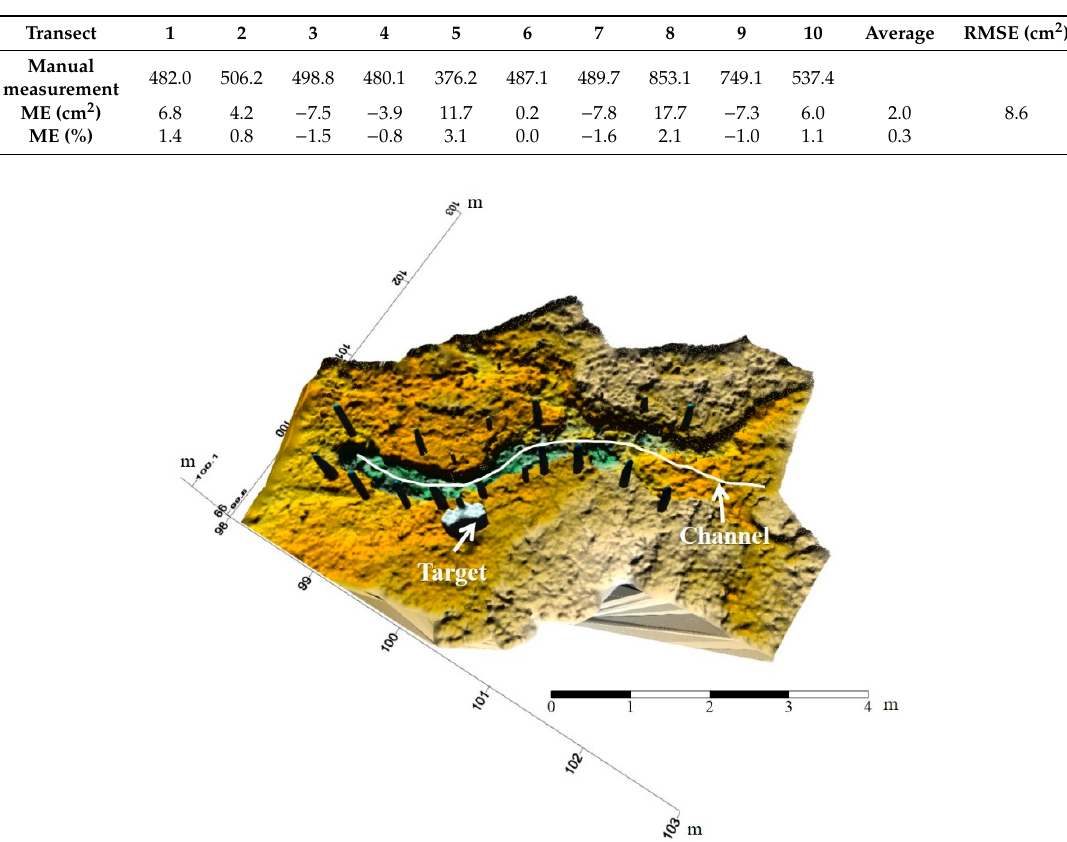
Figure 8. The map of soil surface channel produced from the DEM derived from the CGC-CRP